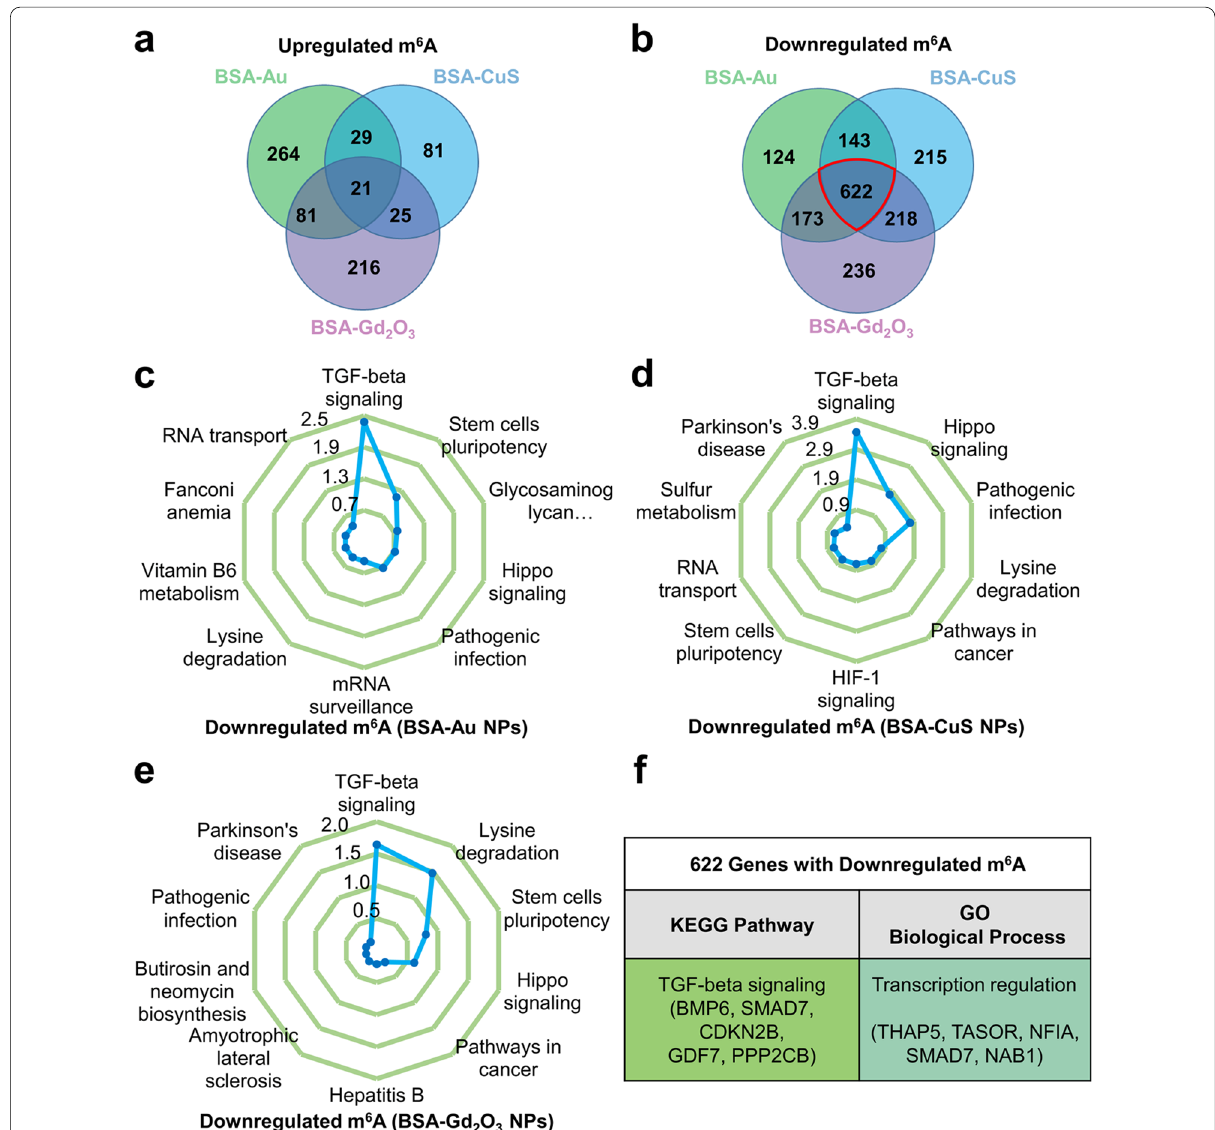
Fig. 4 Functional annotation of the genes with NPs-induced m 6 A changes. a Venn diagram of genes with upregulated m 6 A treated with various NPs. b Venn diagram of genes with downregulated m 6 A treated with various NPs. c–e KEGG pathway analysis of genes with downregulated m 6 A level treated with different NPs. The axis refers to the -log 10 FDR( p value). f The most prominent pathway and biological process from the KEGG and GO analysis of three NPs-shared 622 genes with downregulated m 6 A level,